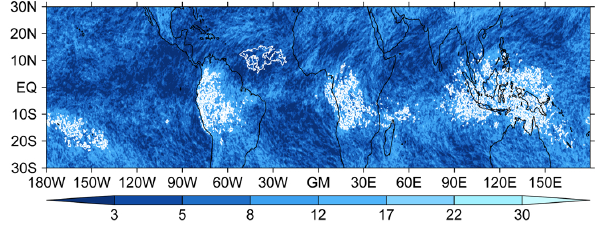
Fig. 5. Map of the tropical belt at 150hPa highlighting regions where higher than average divergence occurs often (brighter colours mean more events, see colourbar) and where ice supersaturation oc- curs at least on ten of the 31 March days (white contours). Higher than average divergence is defined here as δ > 16 × 10 − 6 s − 1 .